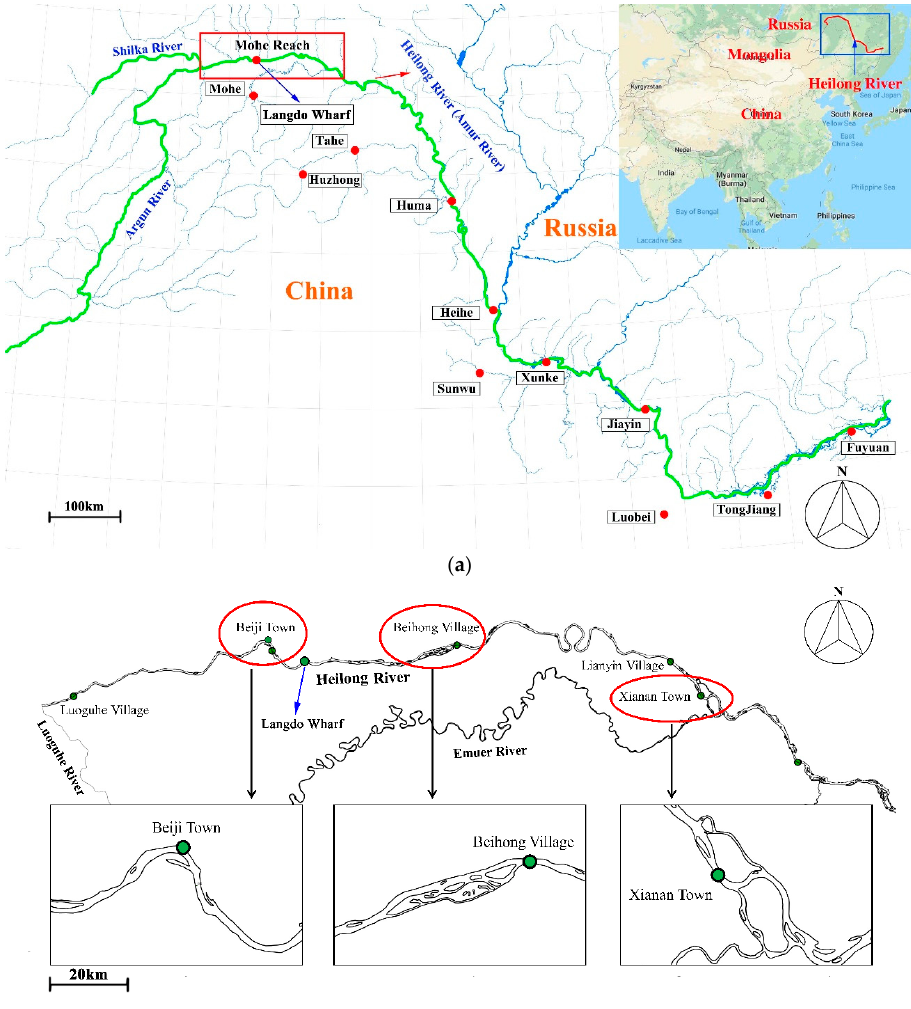
Figure 1. Study area: ( a ) Location of the Heilong River and its major tributaries; ( b ) detail of the Mohe reach on the Heilong River.